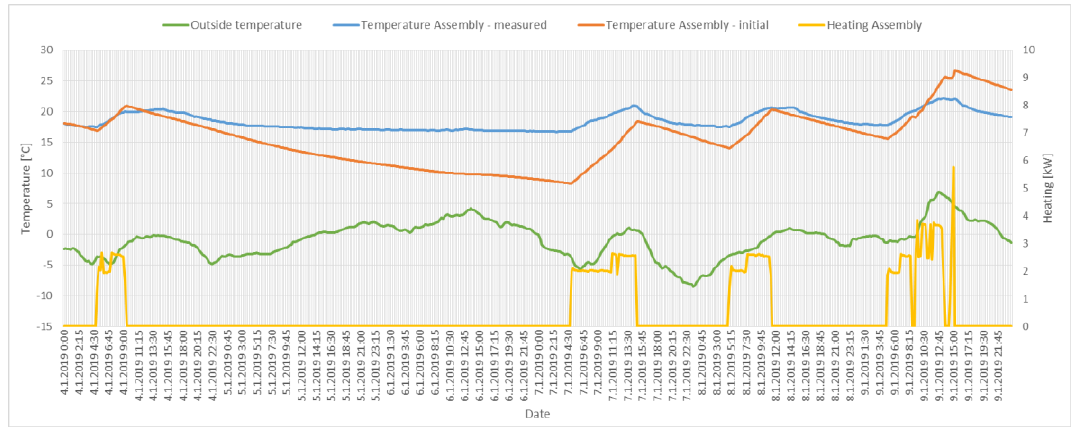
Figure 9. Results of initial model with Winter-1 scenario.